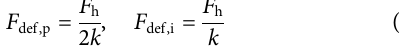
Frontiers in Built Environment |